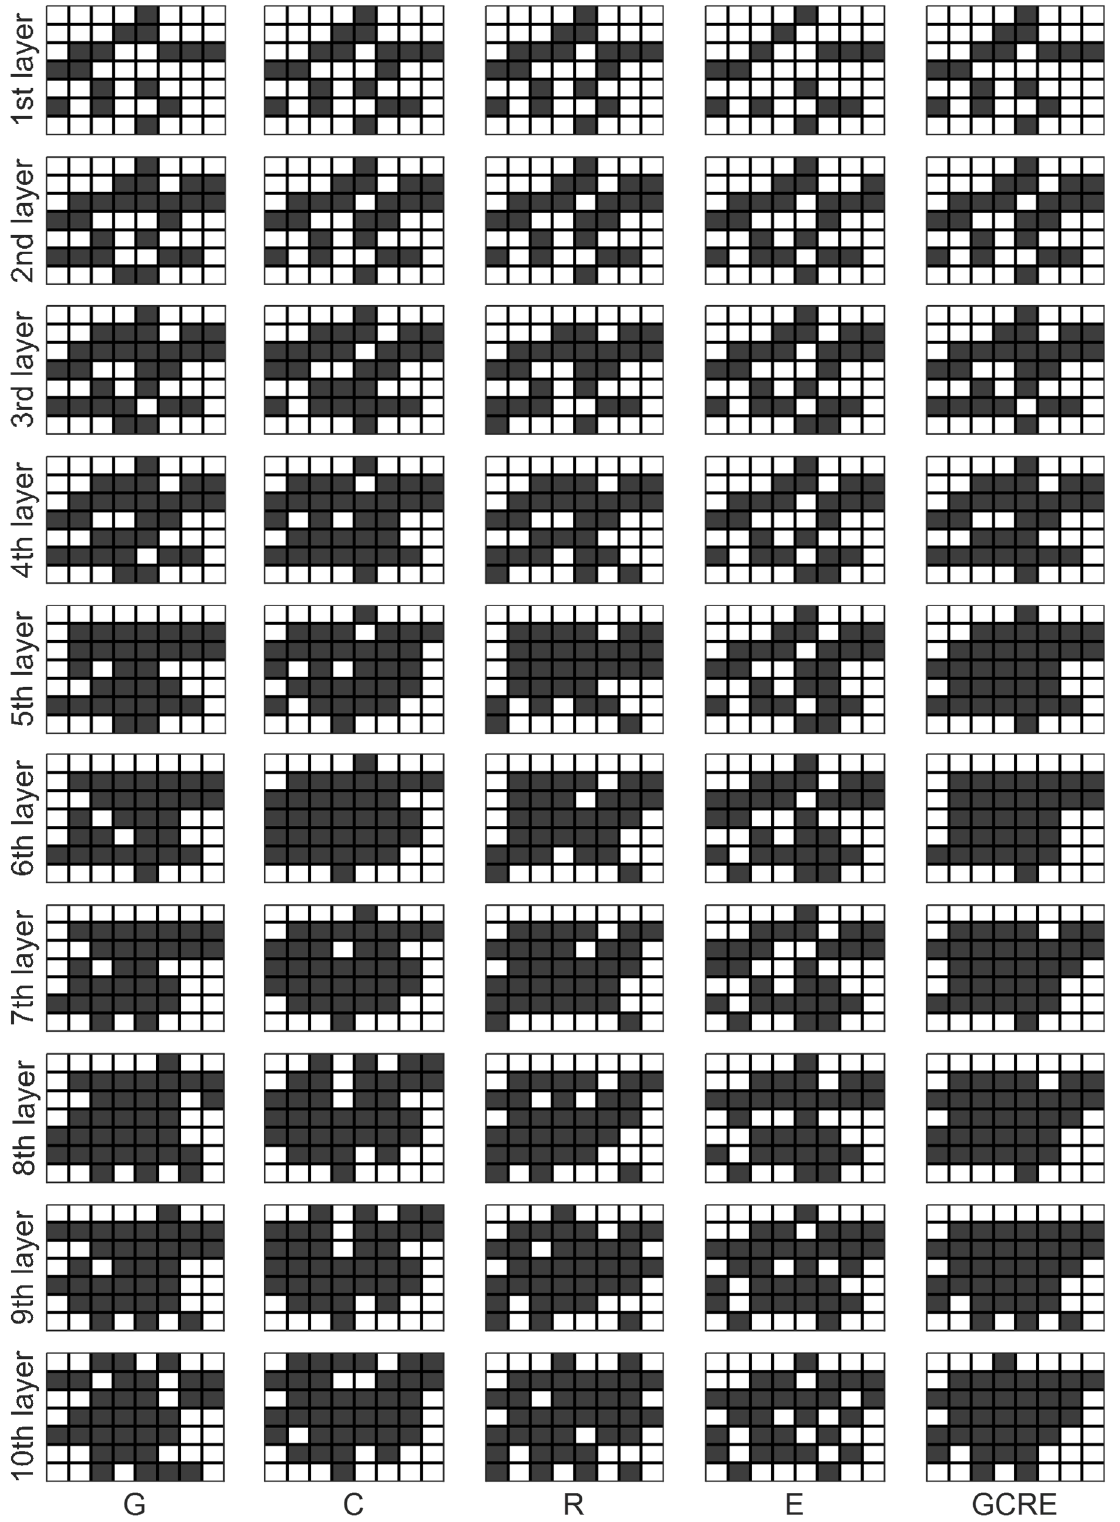
Figure 5. Distribution of voxel with sufficient signal rays at each layer for GPS, BDS, GLONASS, Galileo, and a combination of GCRE.